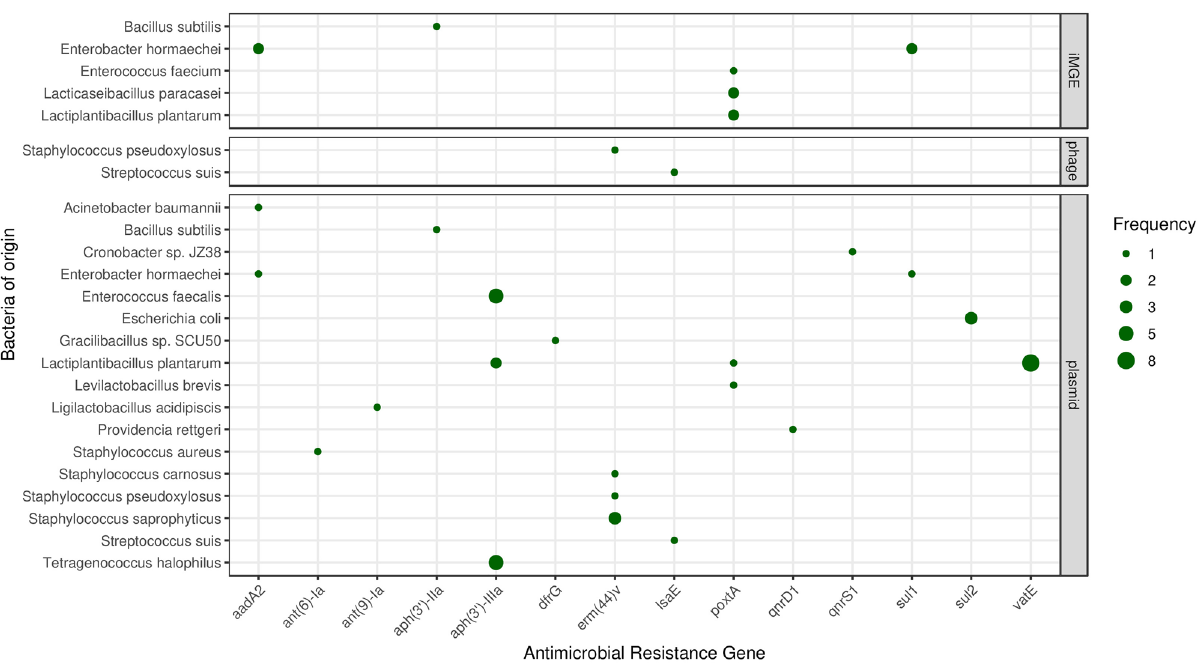
Figure 3. Mobile antimicrobial resistance gene frequency by bacteria of origin. The size of the dots indicates the occurrence frequency of the ARGs flanked by iMGE, positioned in a plasmid or a